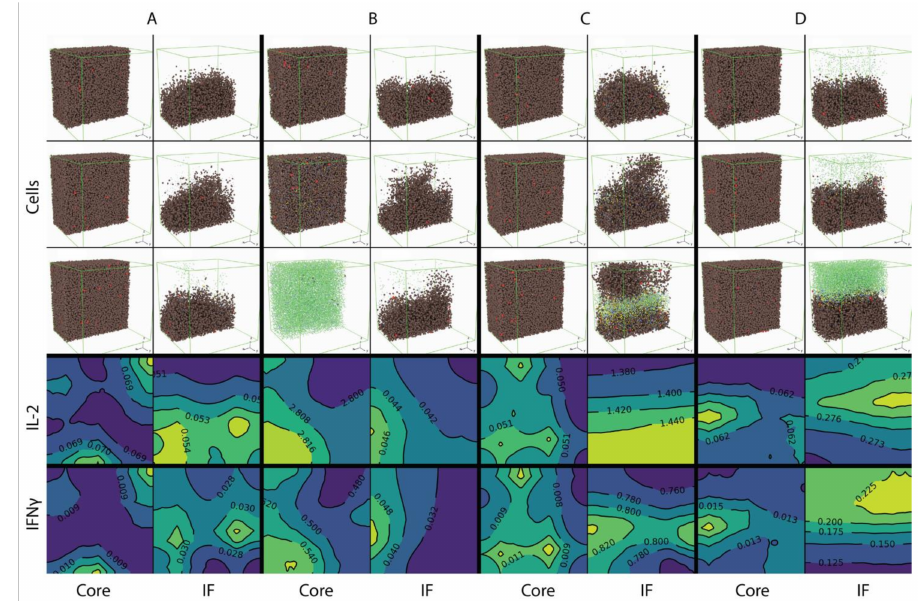
Figure 6. Spatial distribution of different cell types and concentration of IL-2 and IFN γ in tumor core and invasive Figure 4. Cytokine concentration (ng/mL) reflects the concentration in the x – z plane cross section at y = 0.5 mm location. Cell distributions are pretreatment, early treatment and day 200, while cytokine concentrations shown are pretreatment. ( A ) Baseline vascular densities. ( B ) Increased vascular density in the tumor core. ( C ) Increased vascular density in tumor at the invasive front. ( D ) Increased vascular density in normal tissue outside of the invasive